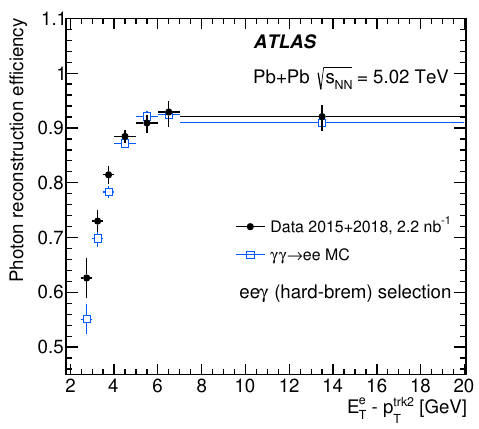
Figure 3 . Photon reconstruction efficiency as a function of photon E γ p trk2 ) extracted from γγ → e + e − events with a hard-bremsstrahlung photon. Data (full symbols) T are compared with γγ → e + e − MC simulation (open symbols). The error bars denote statistical